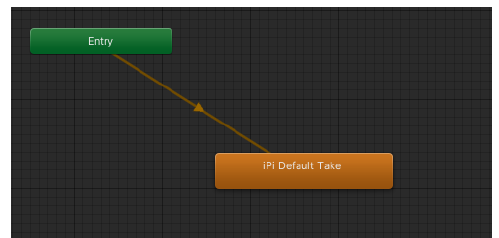
Figure 15. Unity’s Animator Controller